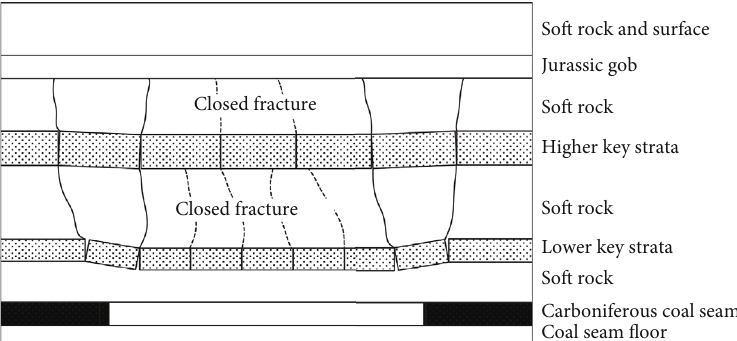
Figure 10: Distribution diagram of gas-conducting fracture fi eld during periodic fracture of the higher key